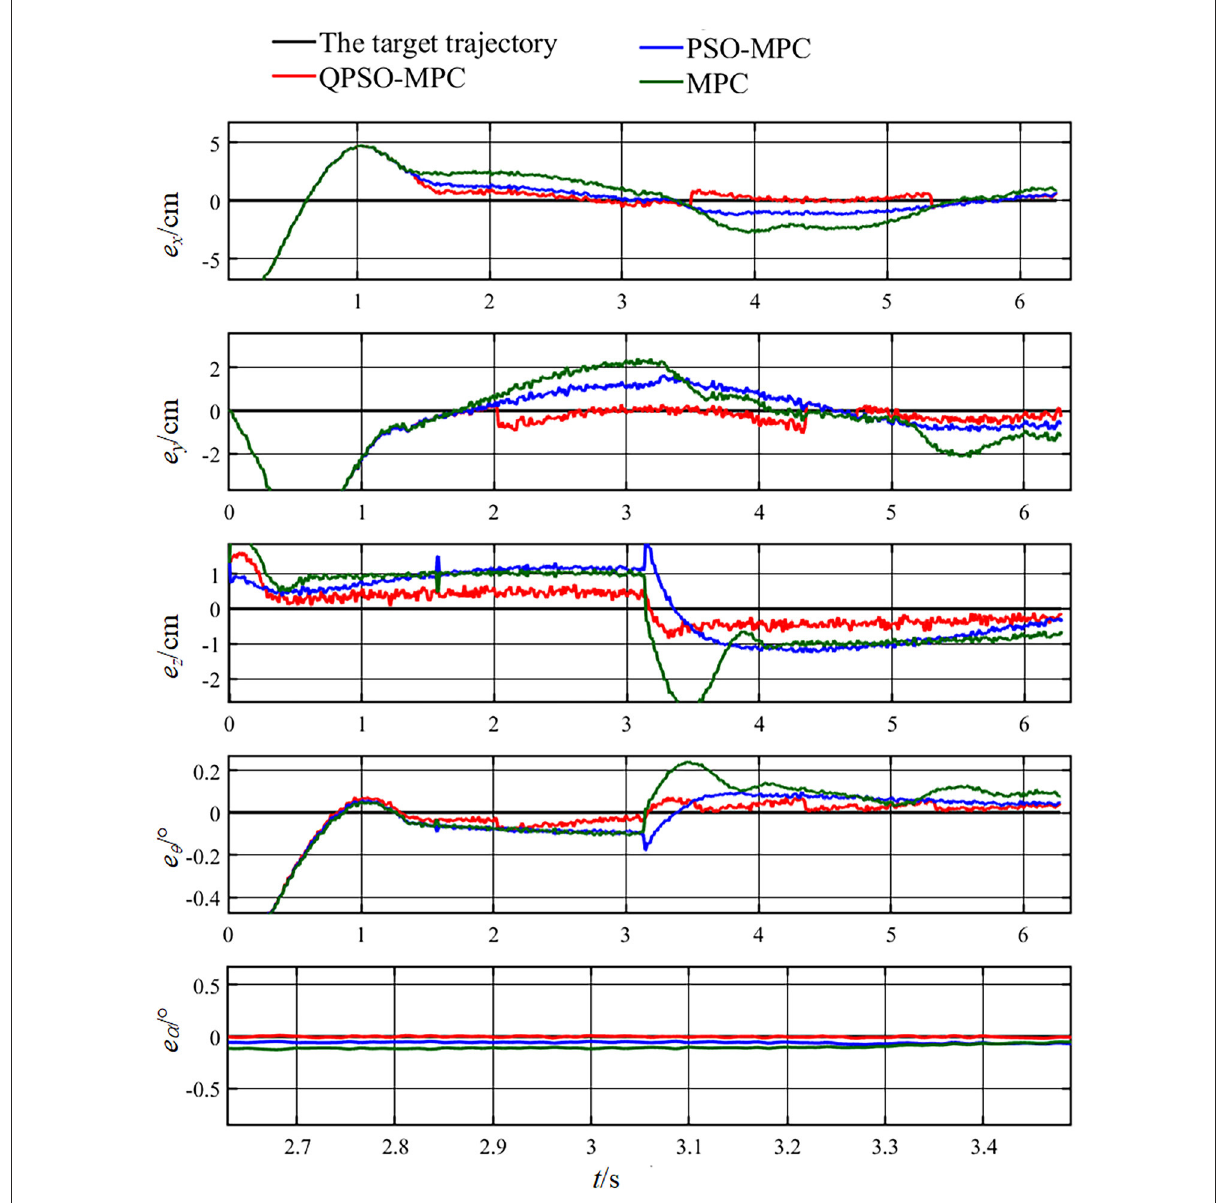
FIGURE9 Tracking errors of the cardioid trajectory